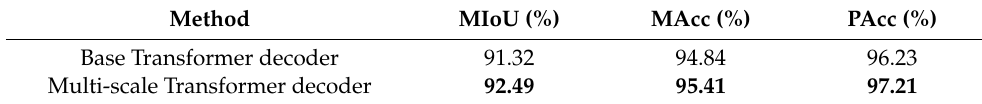
Figure 5. Decoder structure comparison. ( a )Multi-Scale Transforemr decoder. ( b )Transformer de- Table 2. Multi-scale Transformer decoder ablation experiment results. coder